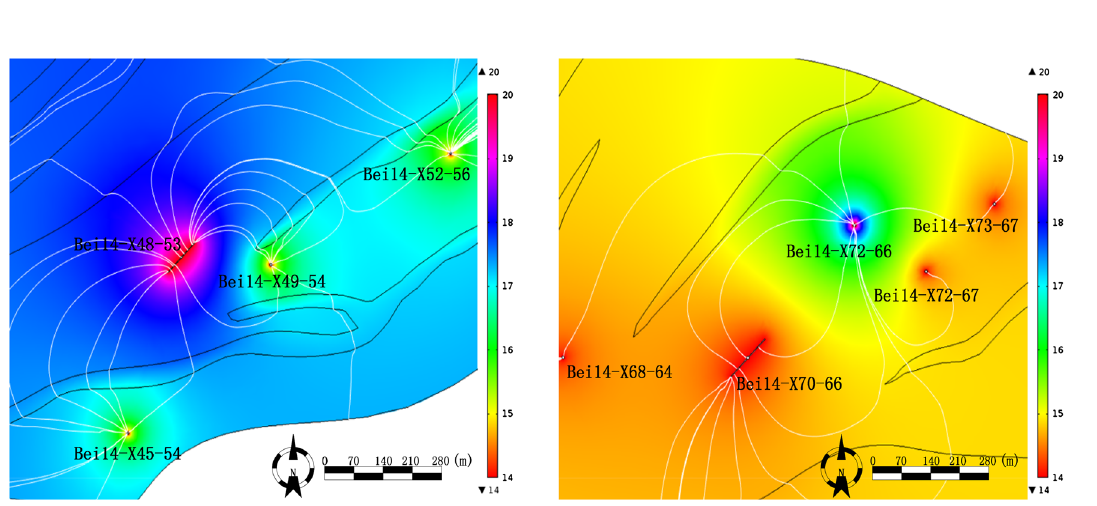
Fig. 6 The distribution of flow field and pressure field near the